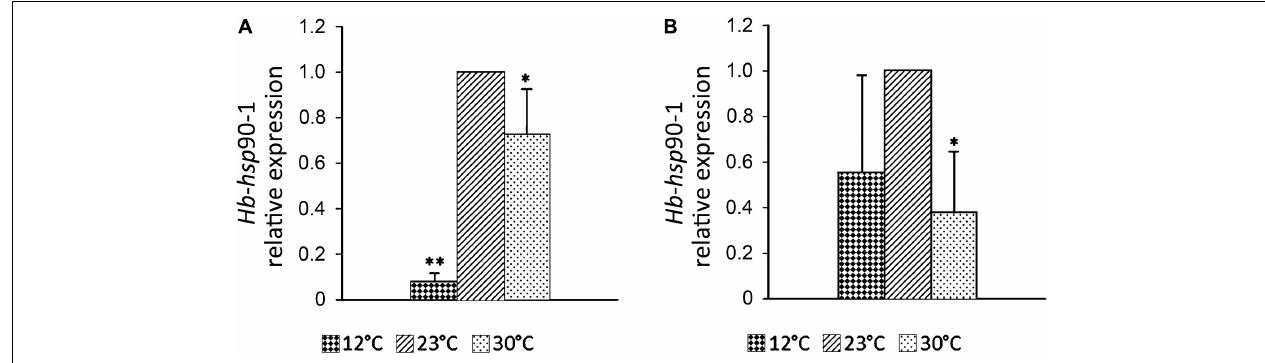
FIGURE 5 | Expression profiles of the Hb - hsp 90-1 of Heterorhabditis bacteriophora at 12 ◦ C, 23 ◦ C, and 30 ◦ C in IJs (A) and adults (B) in aqueous solution. Bars indicate standard error of mean data ( n = 3). Significant differences (* P < 0.01; ** P < 0.05) were found between control and treated nematodes.